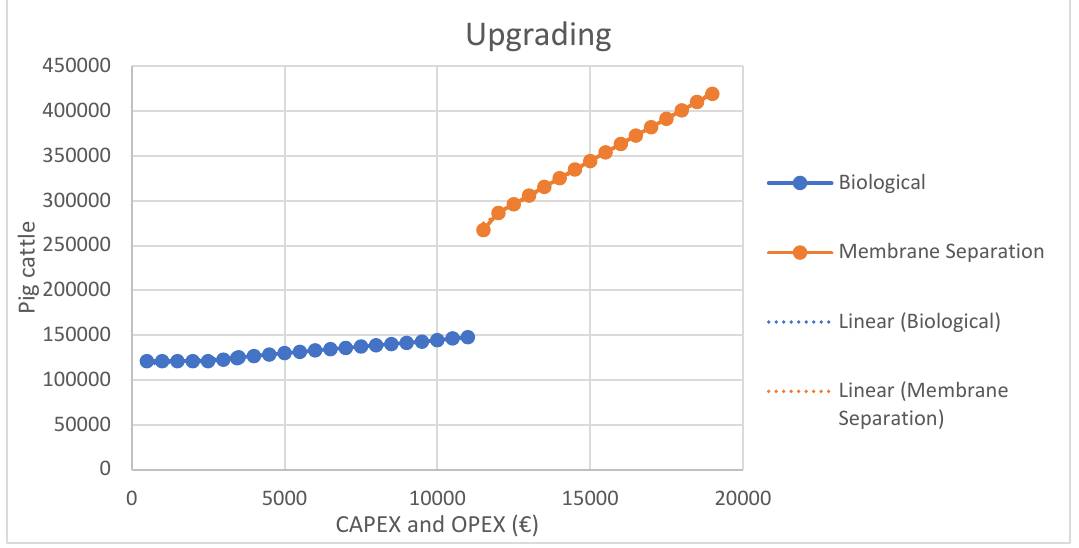
Figure 5. CAPEX and OPEX of upgrading systems.